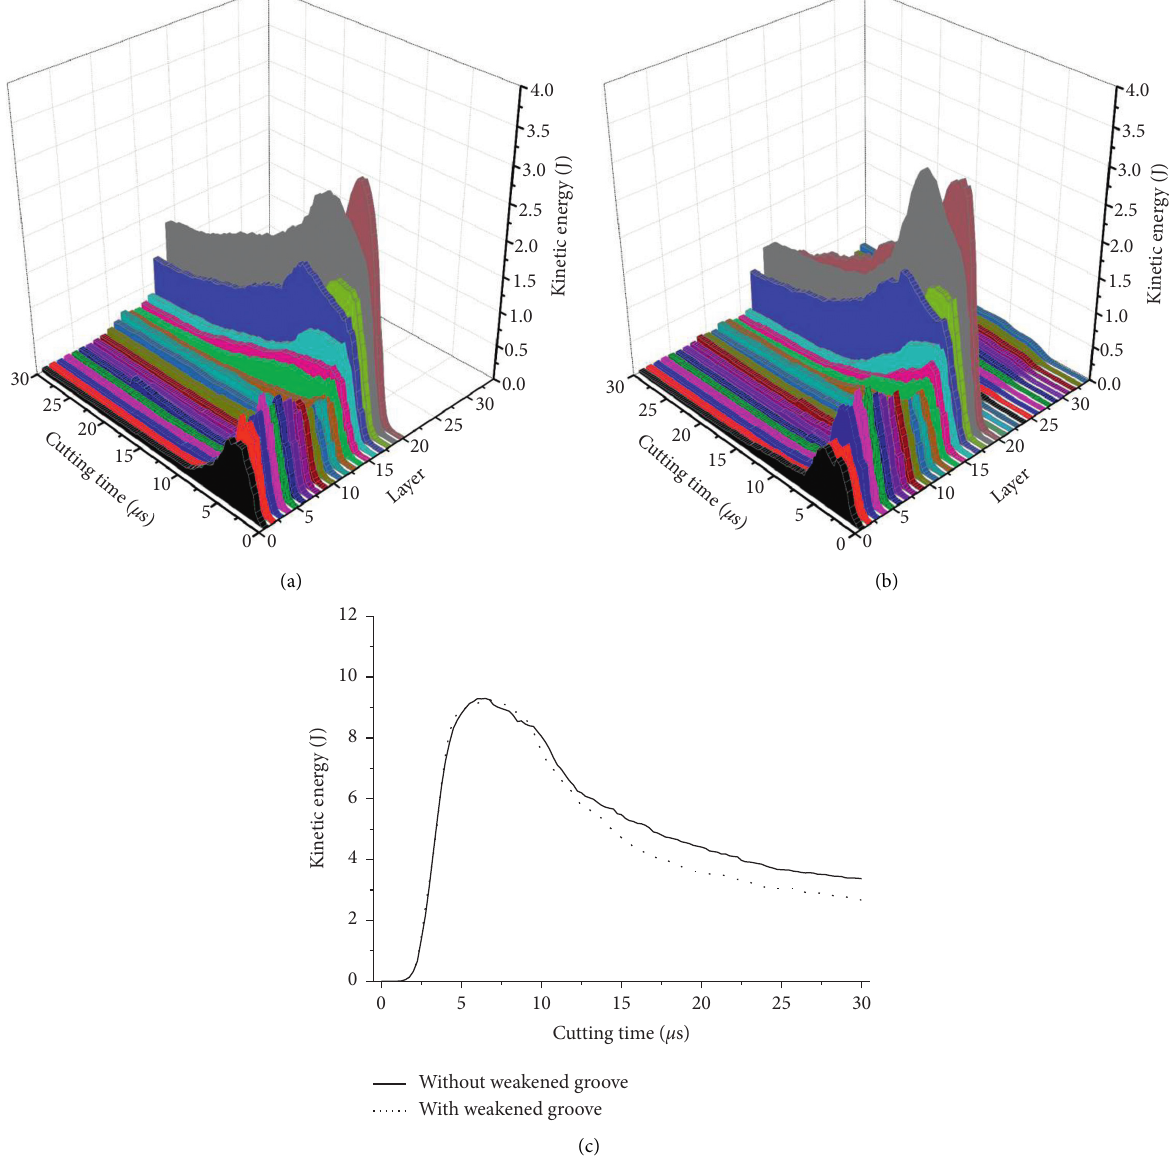
Figure 8: Changes of kinetic energy of sublayers (a) without and (b) with weakening groove; (c) sum kinetic energy of 17–20